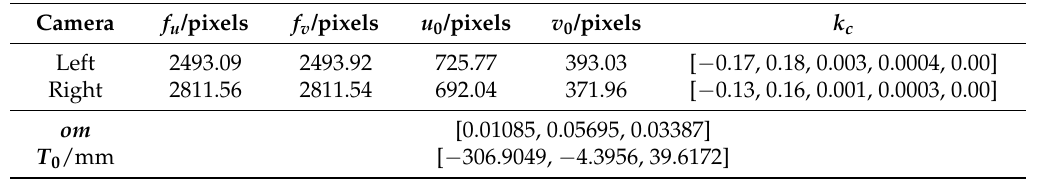
Figure 6. Experimental equipment of the binocular stereo vision.